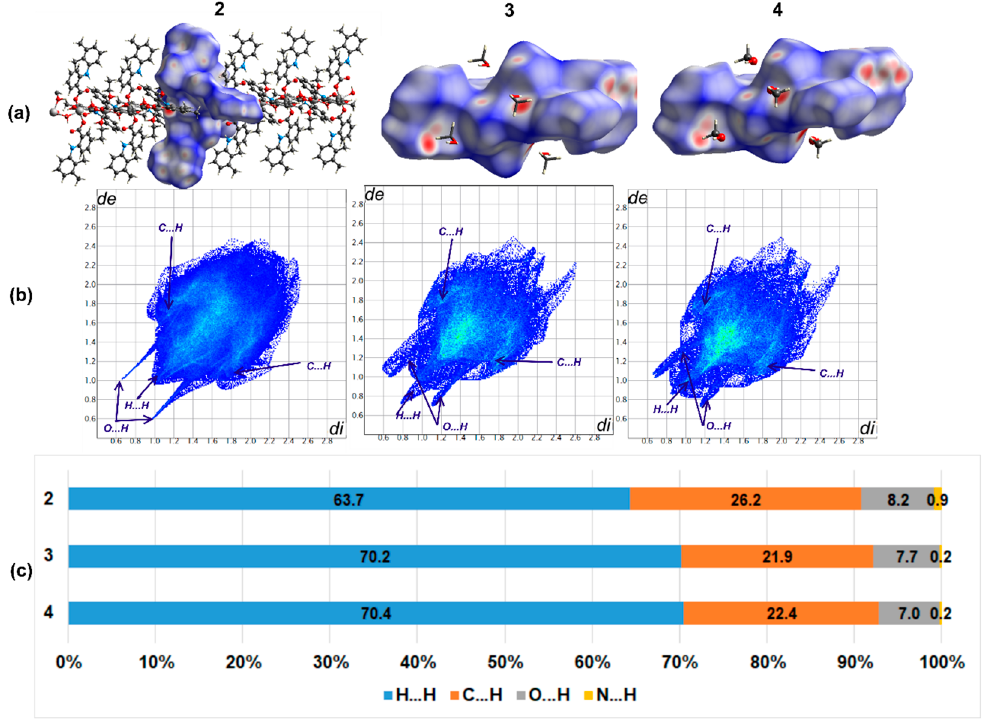
Figure 4. ( a ) Hirshfeld surfaces generated for the mer unit of 2 and the single molecules of 3 and 4 . ( b ) Fingerprint plots generated for respective moieties. Labels indicate regions of specific interatomic interactions. ( c ) The percentage contributions to the Hirshfeld surface areas for intermolecular contacts.